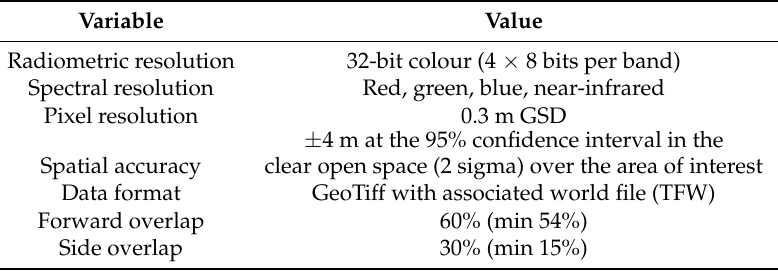
Table 4. Summary of aerial imagery